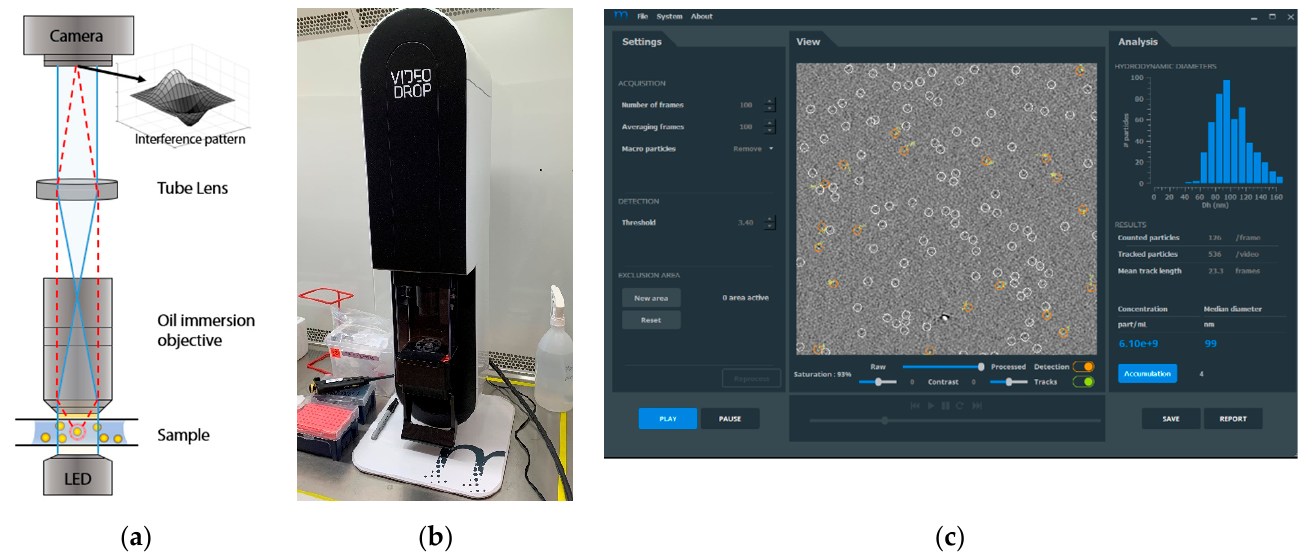
Figure 1. The videodrop system: ( a ) ILM (Videodrop, Myriade France) optical system; ( b ) the Videodrop device installed; ( c ) screenshot of the Videodrop software measurement view.